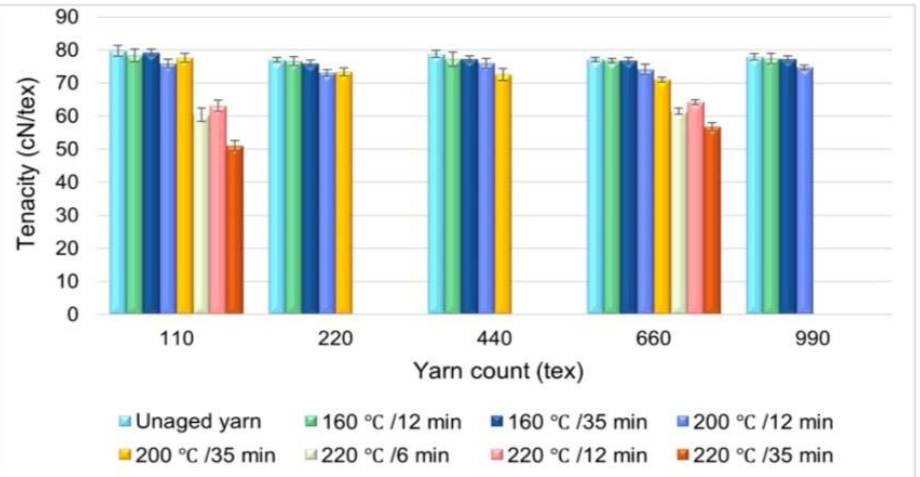
Figure 2. The relationship between the ageing time at ageing temperatures of 160, 200, and 220 °C and yarn strength [32].